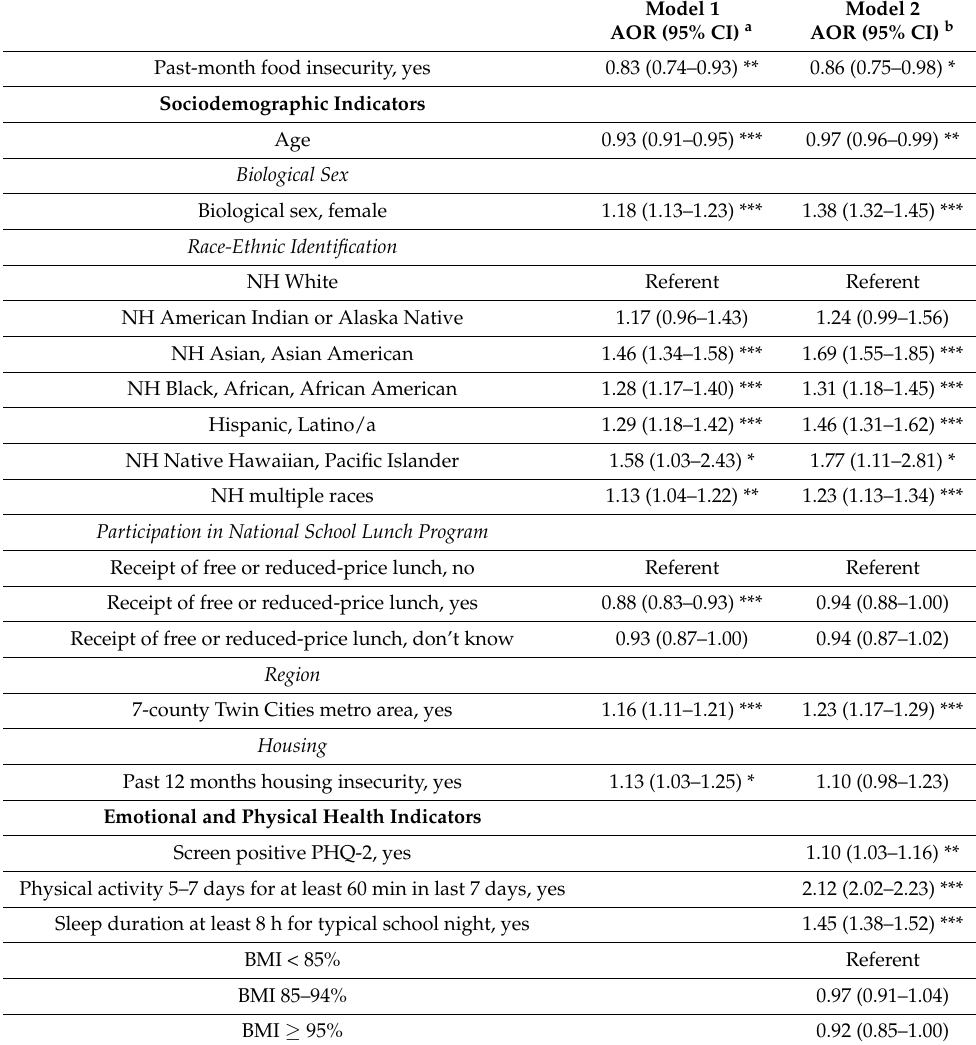
Table 1. Past-Month Food Insecurity and Student Consumption of Vegetables Three or More Times/Day, Past 7